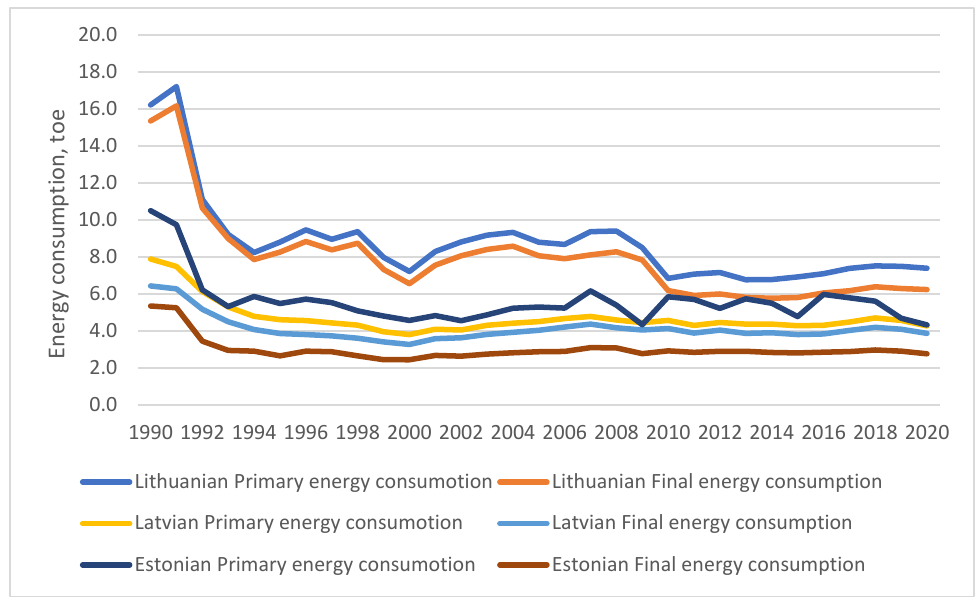
Figure 4. Profile of energy efficiency improvement indicators in Baltics during 1990 – 2020. Source: Created by authors. Based on Reference [44].